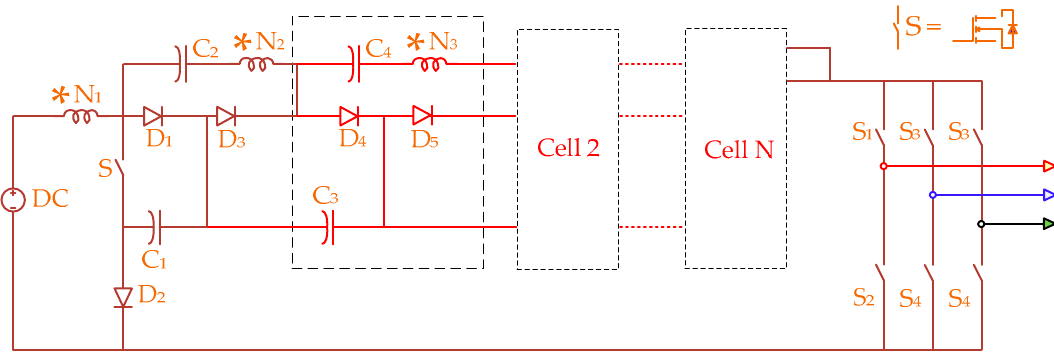
Figure 13. Extended coupled-inductor based quasi-switched boost inverter topologies (CI-qZSI).